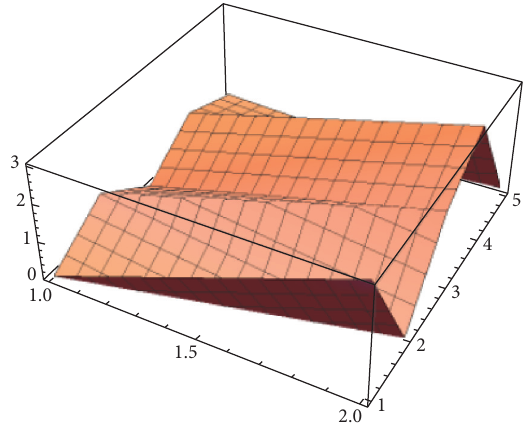
Figure 3: The graphical surface clearly shows that 2 is the fixed point of the map S